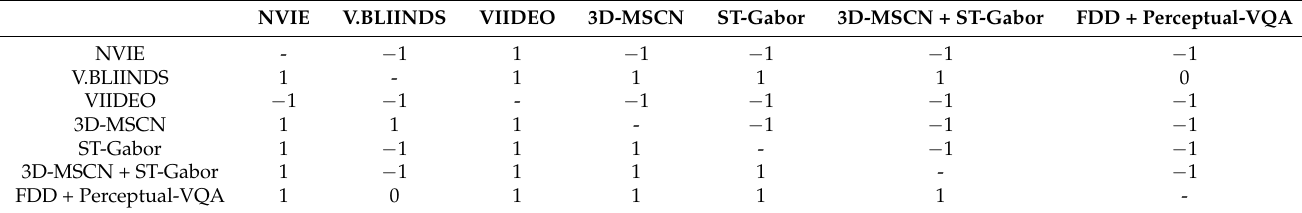
Table 15. A one-sided t -test was carried among 1000 SROCC values measured on LIVE VQC [23] using a 95% confidence level. In this table, “1” (“ − 1”) denotes that the row algorithm is statistically better (worse) than the column algorithm, and “0” stands for no statistical difference between the